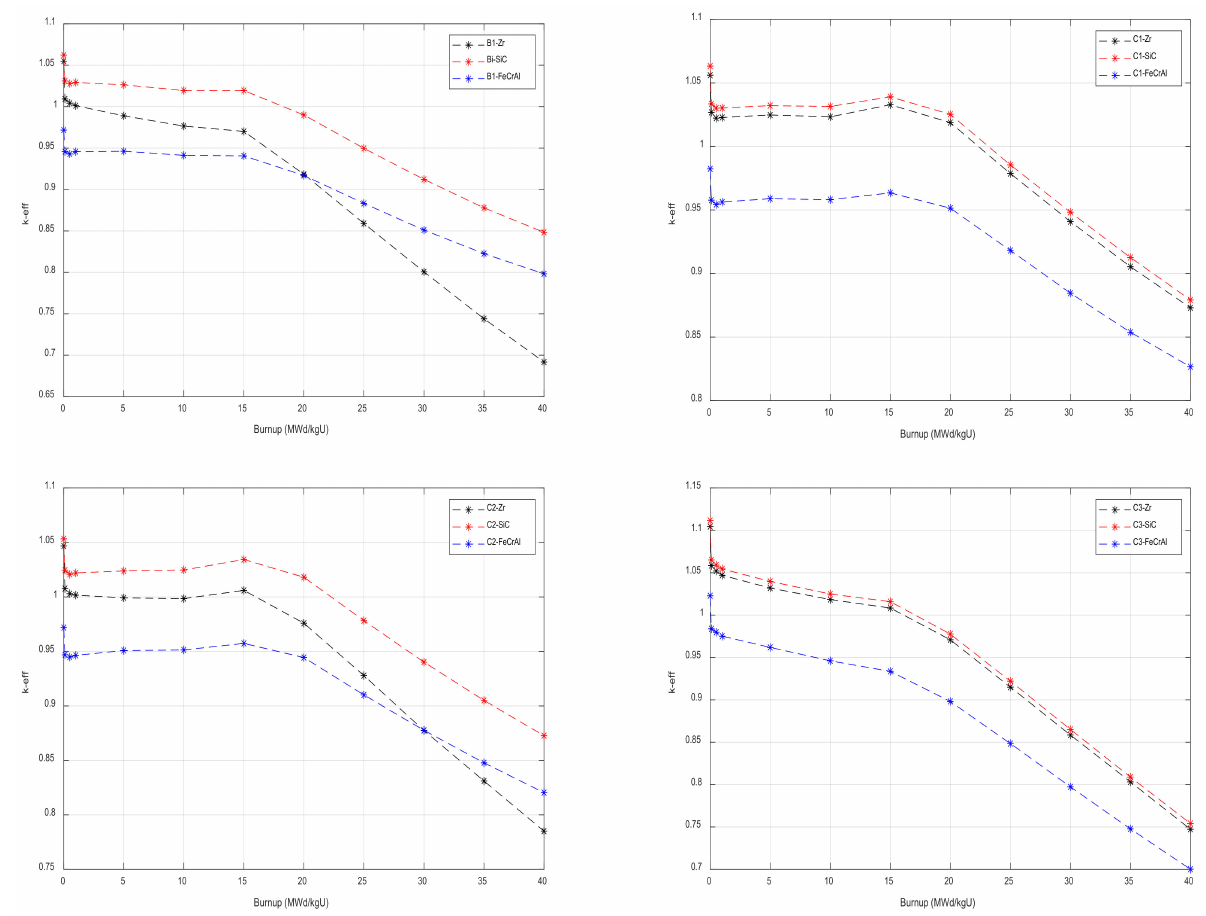
Figure 9. Effective multiplication factor versus burnup days for different fuel assemblies with